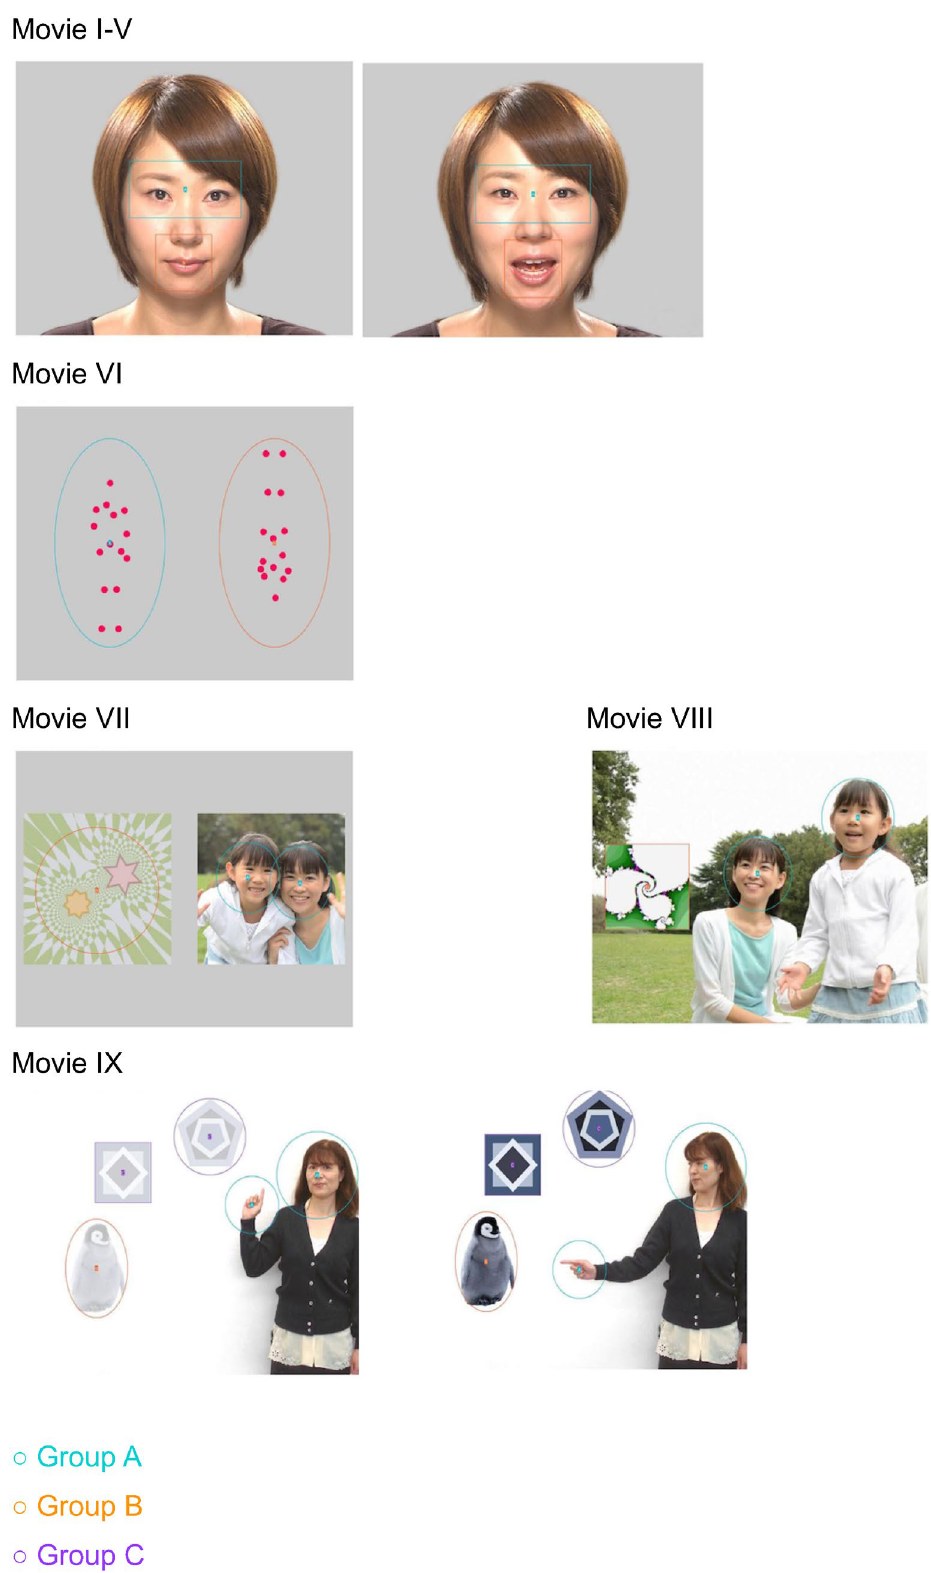
Figure 2. Gazefinder movie samples and their target areas. The human face (Movie I–V) with or without mouth motion; Group A and Group B include the eyes and mouth regions, respectively; Biological motion (Movie VI) Group A and Group B are the upright and inverted images, respectively; Human and geometric patterns (Movie VII and VIII); Group A and Group B are human and geometry, respectively; Joint attention (Movie IX); Group A, Group B and Group C are human, pointed object and geometry areas,